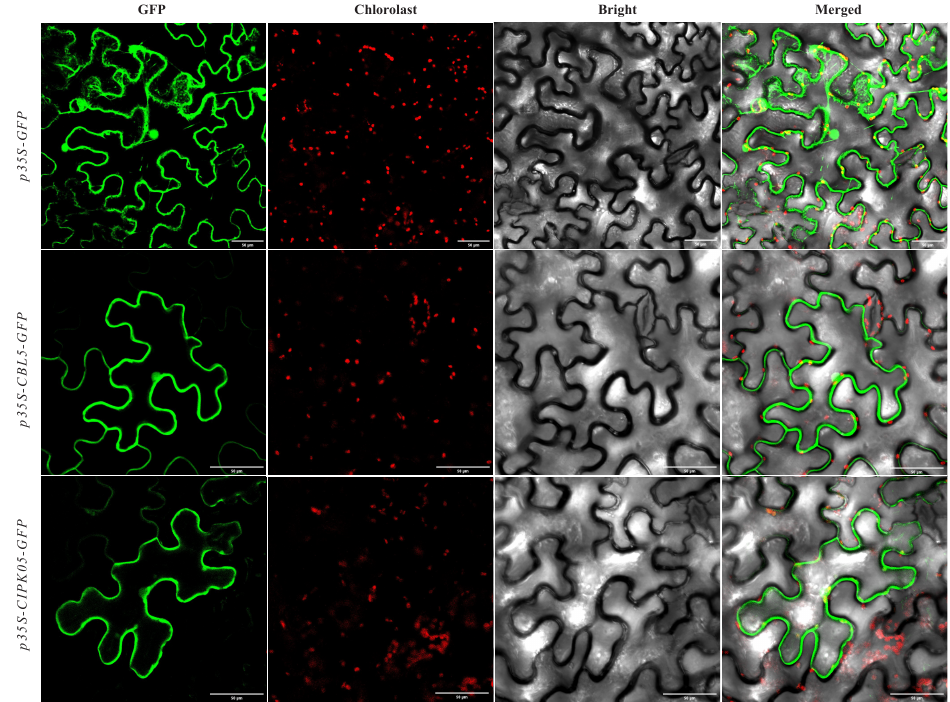
Figure 8. Subcellular localization of the p35S–DoCBL5–GFP and p35S–DoCIPK05–GFP fusion pro- teins in tobacco leaves. Free GFP served as a control. Bars = 50 µ m.